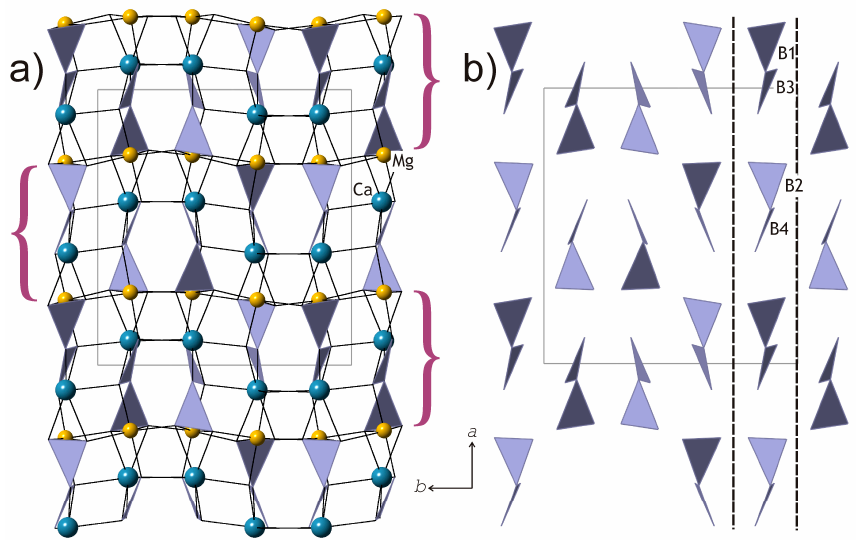
Figure 2. The crystal structure of clinokurchatovite projected along the c axis ( a ) and the arrangement of B 2 O 5 groups ( b ). The dashed lines in ( b ) indicate directions of division of the structure into single slices consisting of diborate groups.